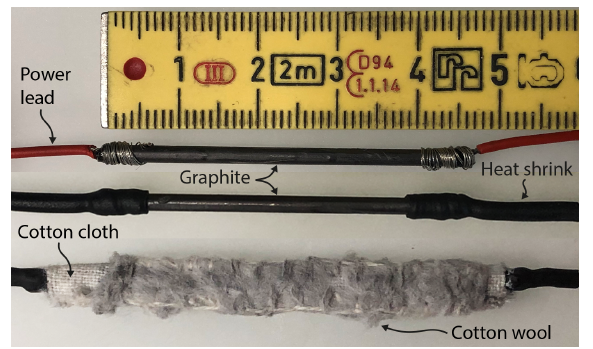
Figure 3. Three steps of constructing the plating tool based on pen- cil graphite as described above. In the bottom, a thin layer of cotton wool is additionally sewn to the fabric for the solution to easily also reach the waveguides’ inner